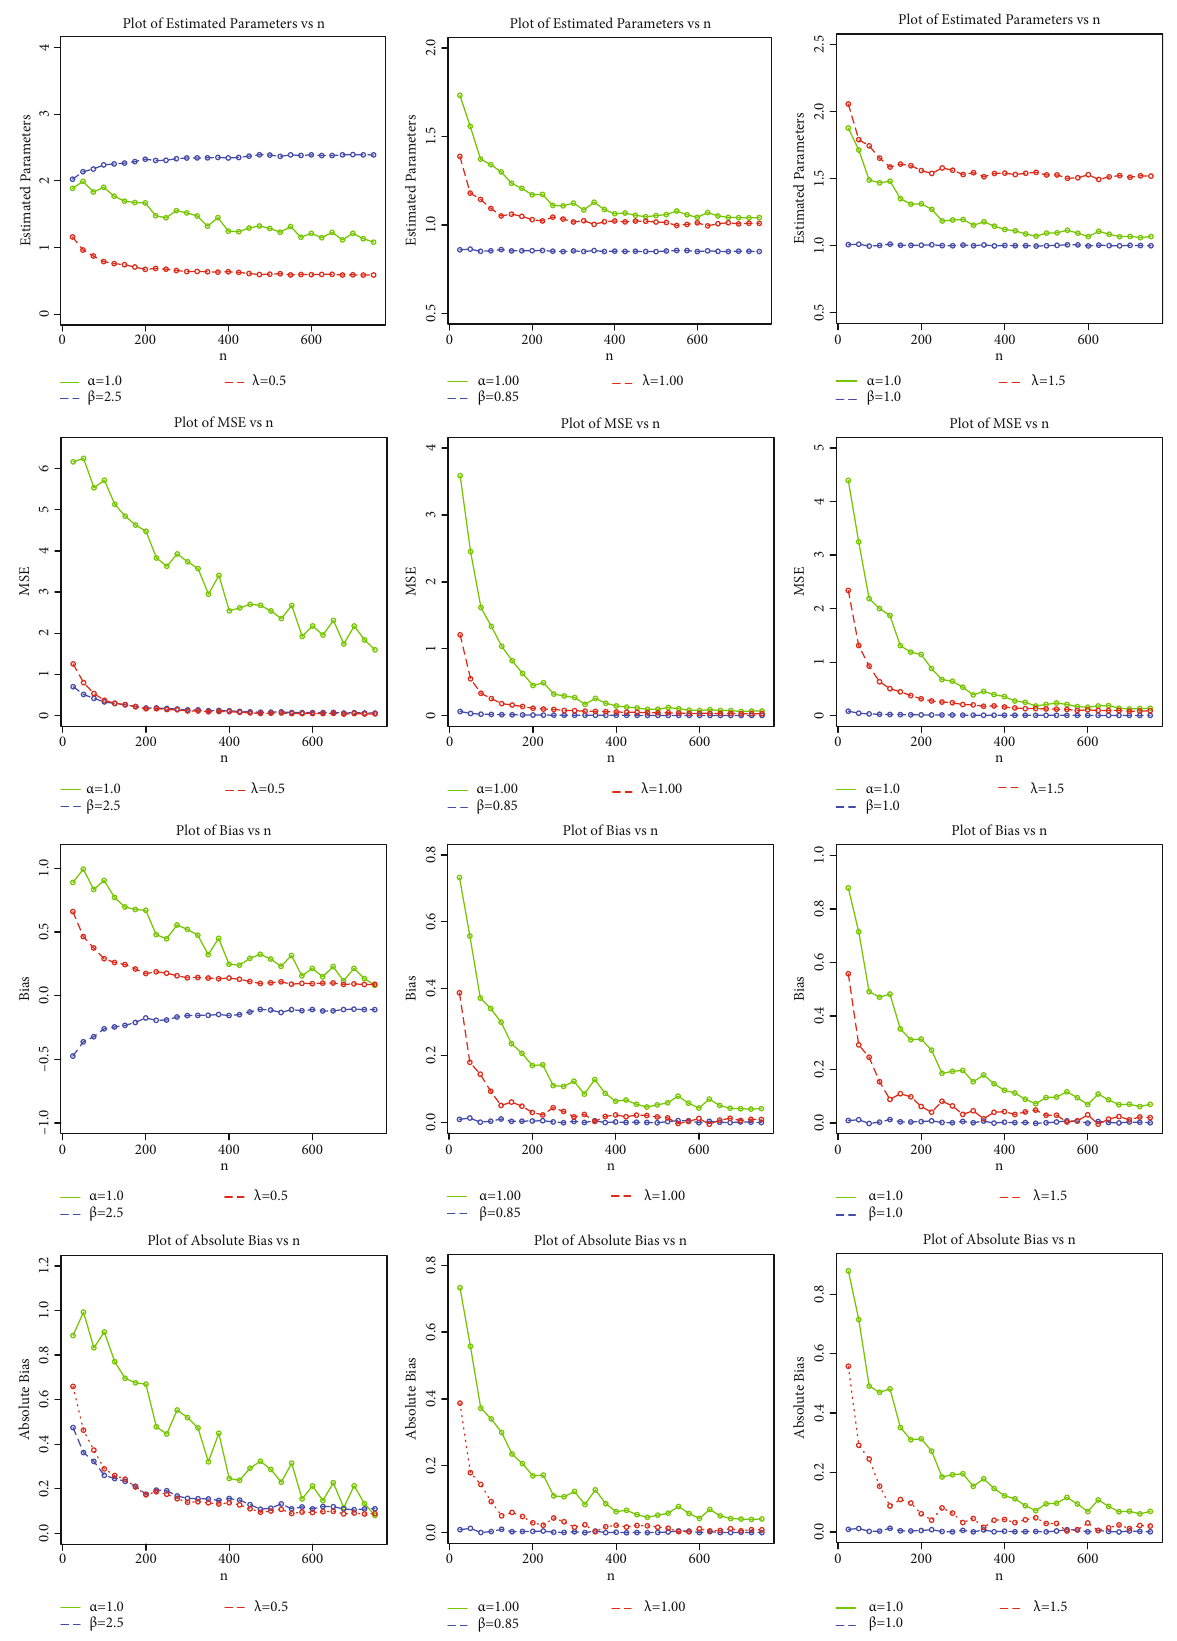
Figure 8: Plots of MLE estimates, MSE, bias, and absolute bias of simulation study at varying sample